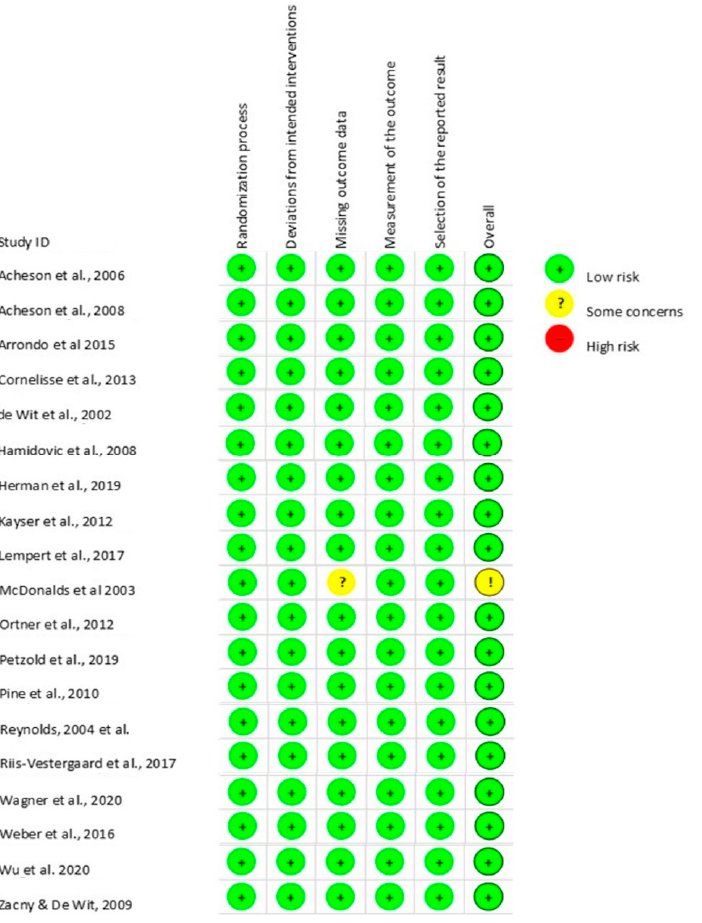
Figure 3. Analysis of Risk of bias. Note. Risk of bias using the Rob 2.0 tool for the 19 selected studies [2,13,22,25–36,38,39,41,42] (Risk +, ?, − ), and the domains evaluated.